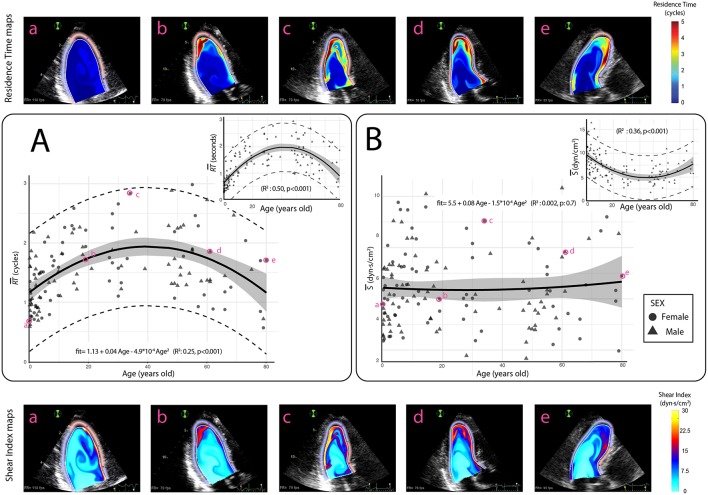
Relationships between age and averaged residence time (RT¯) and shear index (S¯) of blood inside the LV. (A) Age variation of average RT¯ (scaled in cycles). Insert: RT¯ expressed in seconds. (B) Age dependence of S¯ (scaled in dyn·s/cm2). Insert: S¯ expressed in dyn/cm2. Symbols account for sex. The solid black lines indicate the quadratic fits, the shadowed areas indicate the 95% confidence limits for the fittings and dashed lines indicate 95% prediction limits. Upper panels (a-e): RT maps and lower panels (a-e): S maps for selected patients (in magenta).